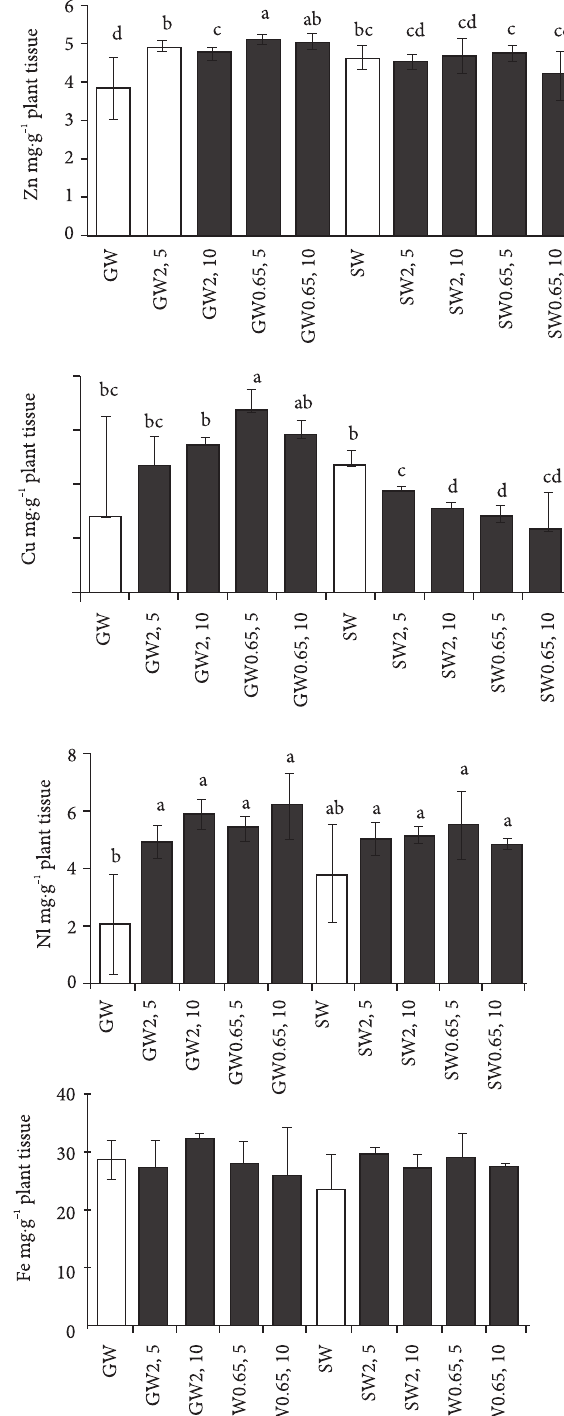
Figure 4. Mean±SD of heavy metal accumulation in aboveground biomass of spinach for heavy metals in response to various treatments; GW-ground water, SW-wastewater, 2, 5-soil amended with large particle size biochar at 5% amendment rate, 2, 10-soil amended with large particle size biochar at 10% amendment rate, 0.65, 5-soil amended with small particle size biochar at 5% amendment rate, 0.65, 10-soil amended with small particle size biochar at 10% amendment rate. Bars with different letters indicate significant difference at P ≤